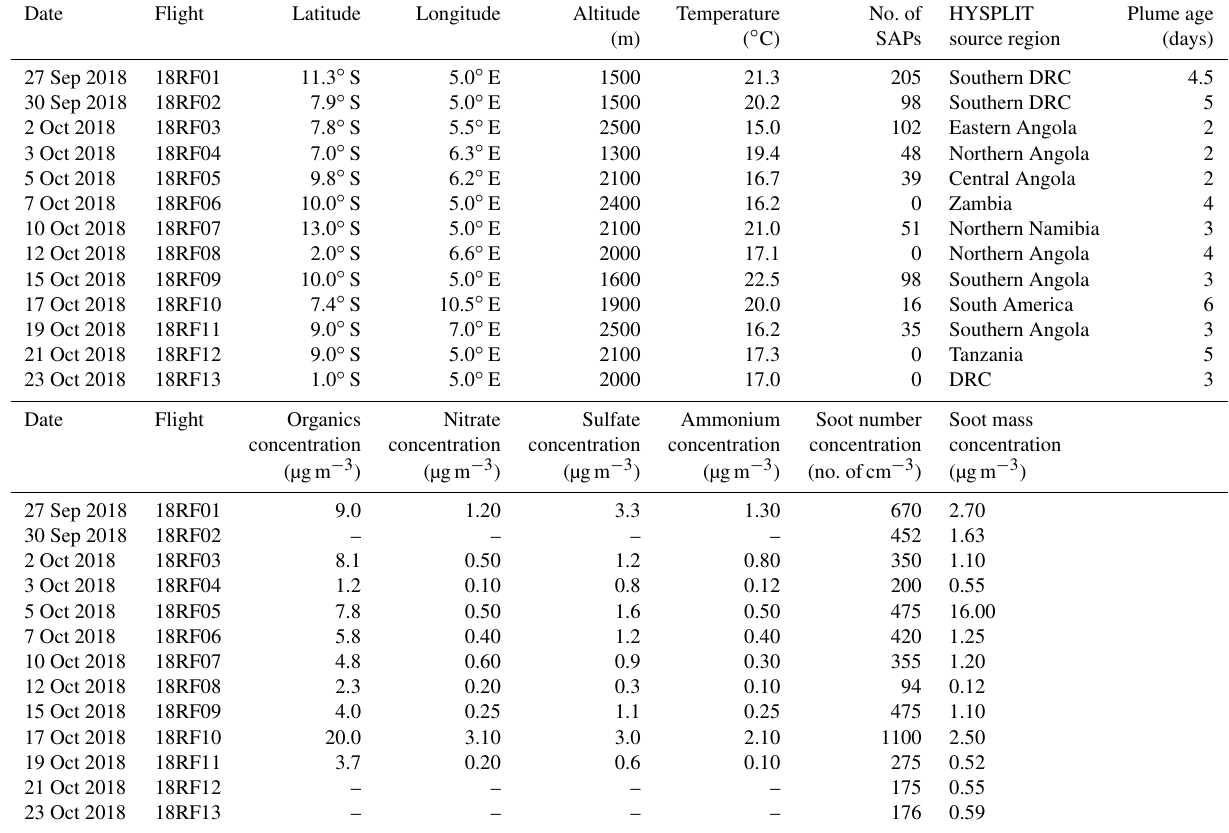
Table 2. The 2018 research flights conducted between 27 September and 23 October 2018. All concentrations and temperature values are 5min averages. Some data values were not available and were left blank. Soot number and mass concentrations were obtained from the SP2. Organics, nitrates, sulfates, and ammonium were obtained from the AMS. Plume age was determined from HYSPLIT and WRF models. Note: DRC is the Democratic Republic of